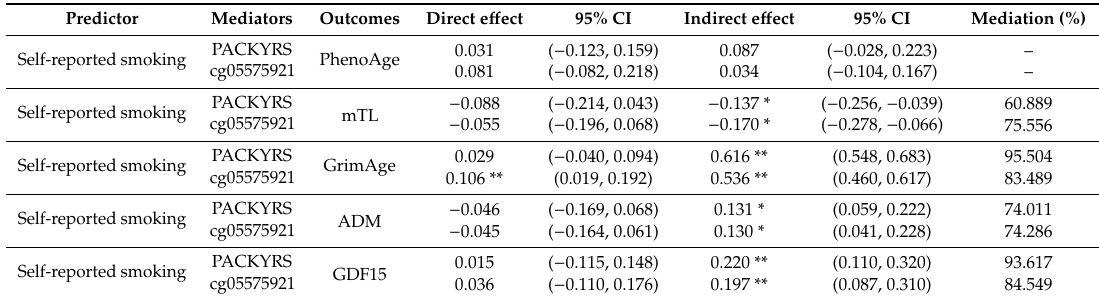
Table 5. Test of direct and indirect e ff ects of self-reported cigarette consumption (past 8 years), excluding former smokers who were not also current smokers, on epigenetic aging through DNA methylation-based estimate of smoking pack-years and cg05575921 (N = 470).